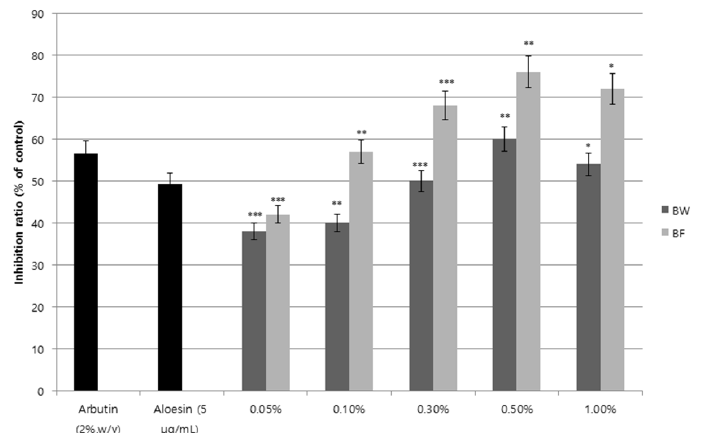
Figure 5. Comparison of inhibiting mushroom tyrosinase activities in adding various concentrations of two extracts of aloe skin leaf, and 5 µ g/mL aloesin and 2% arbutin. BW: Water extract of aloe skin leaf at 100 ◦ C for 24 h. BF: Fermented extract of aloe skin leaf fermented with L. plantarum BN41 at 37 ◦ C for 3 days and further extracted by an ultrasound generator at 20 kHz for 4 h. The mean values ± SD for separate triplicate experiments are shown, and error bars indicate the SD. The significance of the difference was set to * p < 0.05, ** p < 0.01 and *** p < 0.001 compared with two samples, BW and BF.